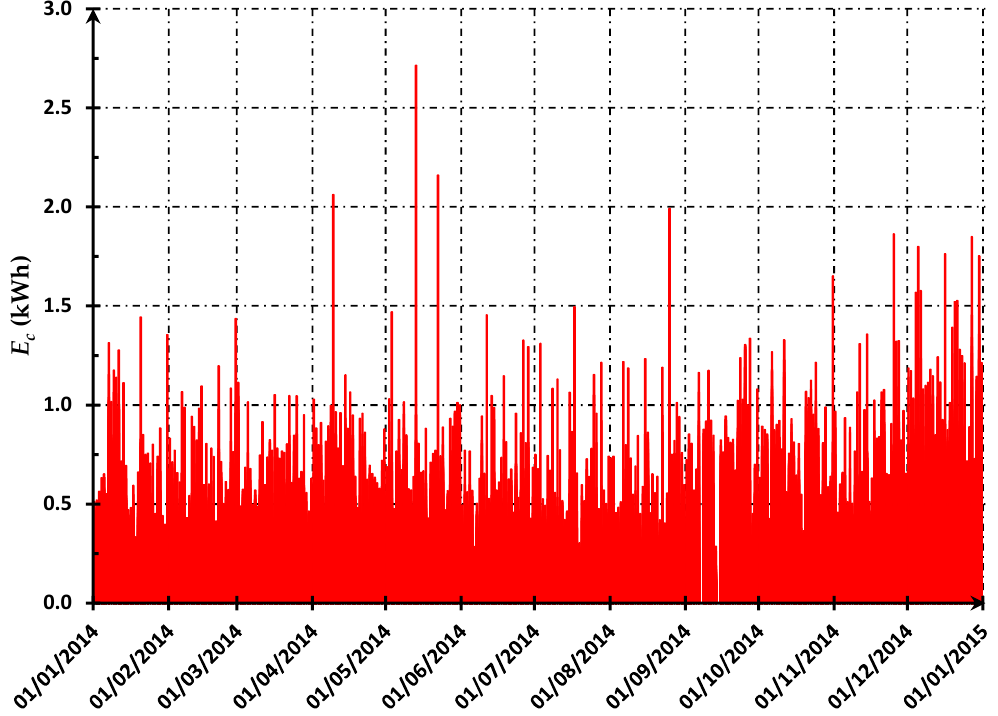
Figure 12. Consumption of active energy (Ec) in 2014.